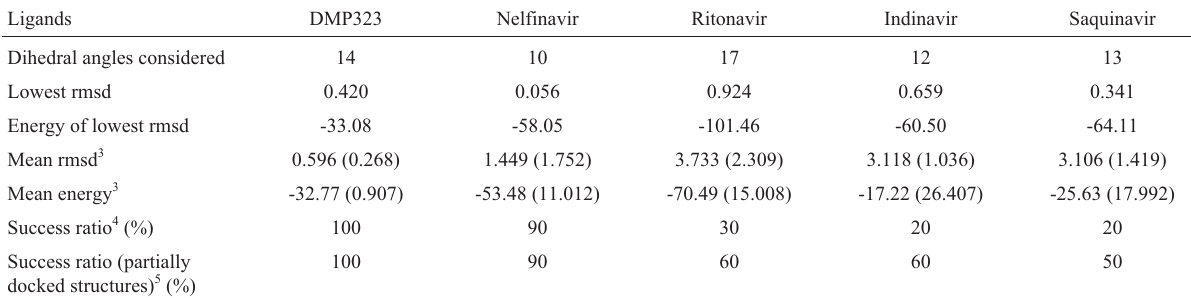
Table 4 - Flexible docking results using the Cauchy distribution without the more internal dihedral